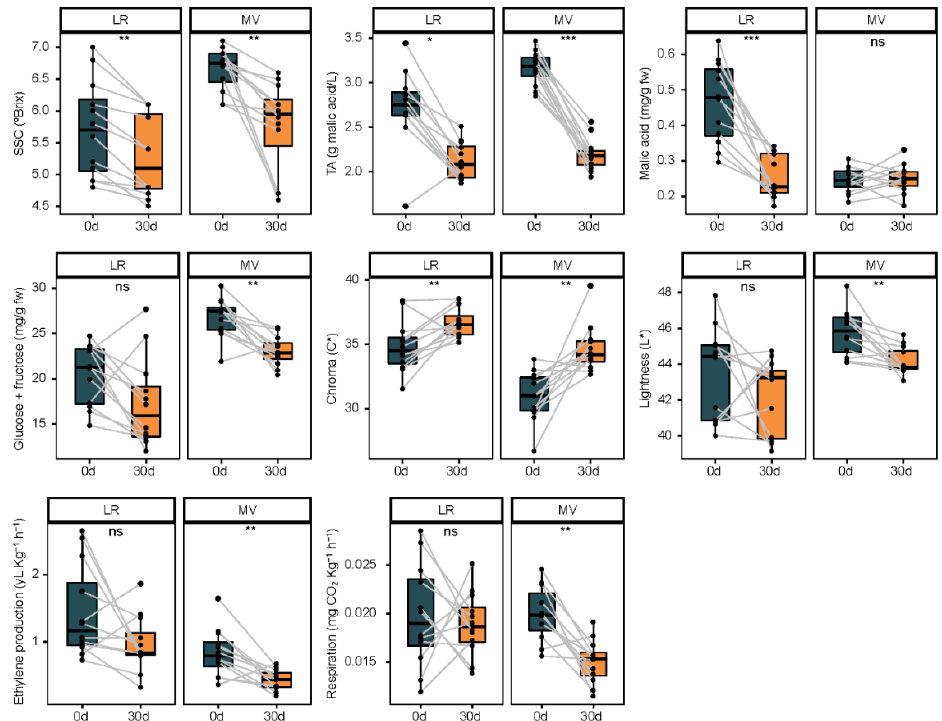
Figure 2. Box plots (25th–75th percentile; center line, median) showing the evolution of physical, chemical and physiological traits after 30 days of storage. Lines connect the values of replicates. Within each genotype (LR: landrace; MV: modern cultivar) ***, **, *, and ns indicates significant at <0.001, <0.01, <0.05 levels, and non-significant differences between 0 and 30 days,